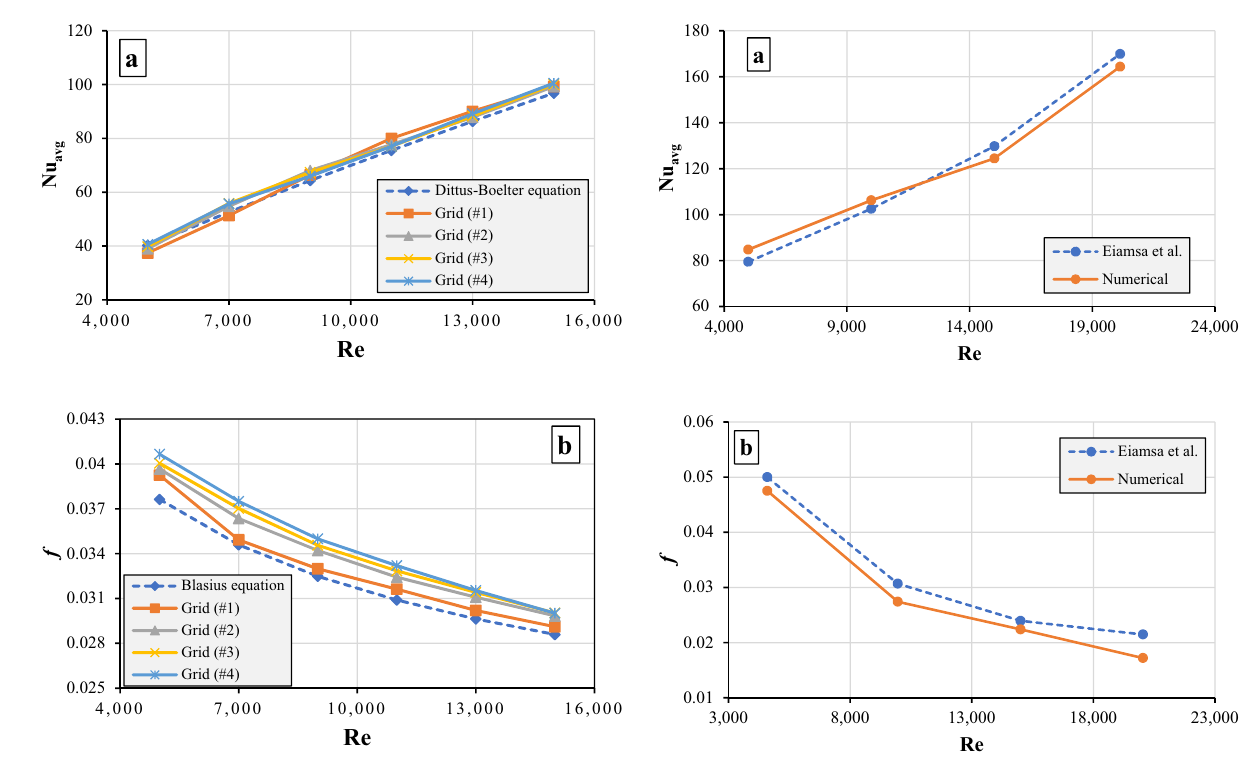
Figure 3: Comparison between the experimental [ 45 ] and numer - ical results: ( a ) average Nusselt number and ( b ) friction factor for